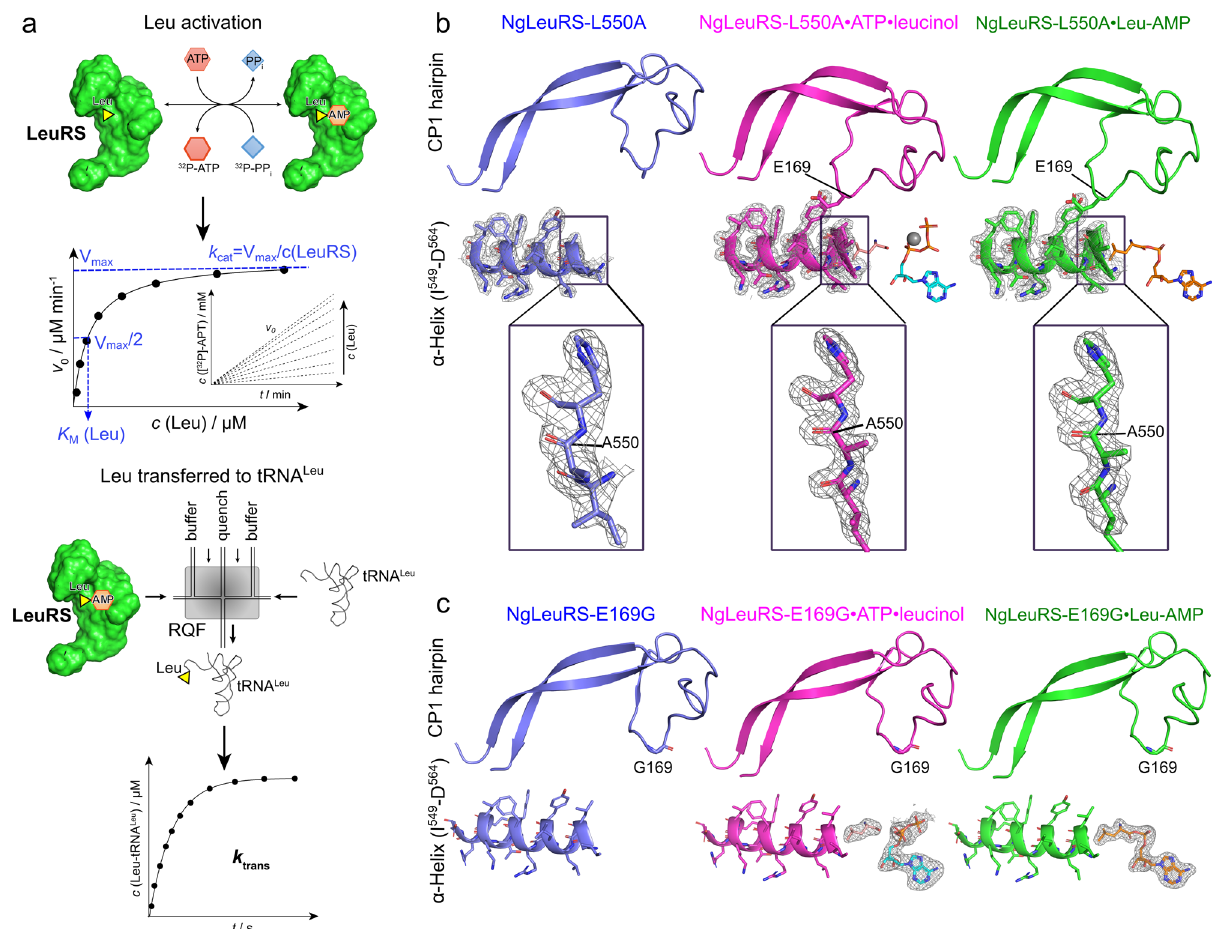
Fig. 4 The effects of L550A and E169G mutants on NgLeuRS catalytic ef fi ciency. a Schematics of assays for Leu activation (top) and Leu transfer (bottom). The former is performed by ATP-PPi exchange assay to measure the effects of L550A and E169G mutants on Leu activation while the latter was used to evaluate the second stage Leu transfer to tRNA Leu . b Upper panels: the relative position of the CP1 hairpin to the L550A-containing α -helix in the NgLeuRS-L550A mutant in different trapped catalytically states. Lower panels: zoom of the L550A region. The CP1 hairpin remains in the closed conformation following Leu-AMP formation. 2Fo-Fc electron density maps (gray mesh) are all countered at 1.5 σ . c Relative position of CP1 hairpin to the L550-containing α -helix in NgLeuRS-E169G mutant. The CP1 hairpin of the E169G mutant remains in an open conformation during Leu activation. Omit maps (gray mesh) of ligands are countered at 3.5 – 5 σ . In b , c the CP1 hairpin is shown as cartoon backbone representations while the L550-containing α - helix is a mixed cartoon and stick representation. The ligands are shown as sticks while the catalytic magnesium ion is shown as a gray Comparison of the captured apo and pre-transition states of both mutants show the same large domain movement, including closure of the active site by the CP1 hairpin and structurally associated α -helix (M 84 -N 93 ), that were seen for the WT structures. Despite the occurrence of these substrate-induced changes, including the shift of the priming loop, no peptide-plane fl ip was observed in either mutant pre-transition state structure. This is likely the result of the absence of the clash between the side chains of E169 of the CP1 hairpin and A550/G550 although the side chain of E169 maintains the same interactions as seen for the WT pre-transition structure (Fig. 4 and Supplementary Fig. 3a, b).